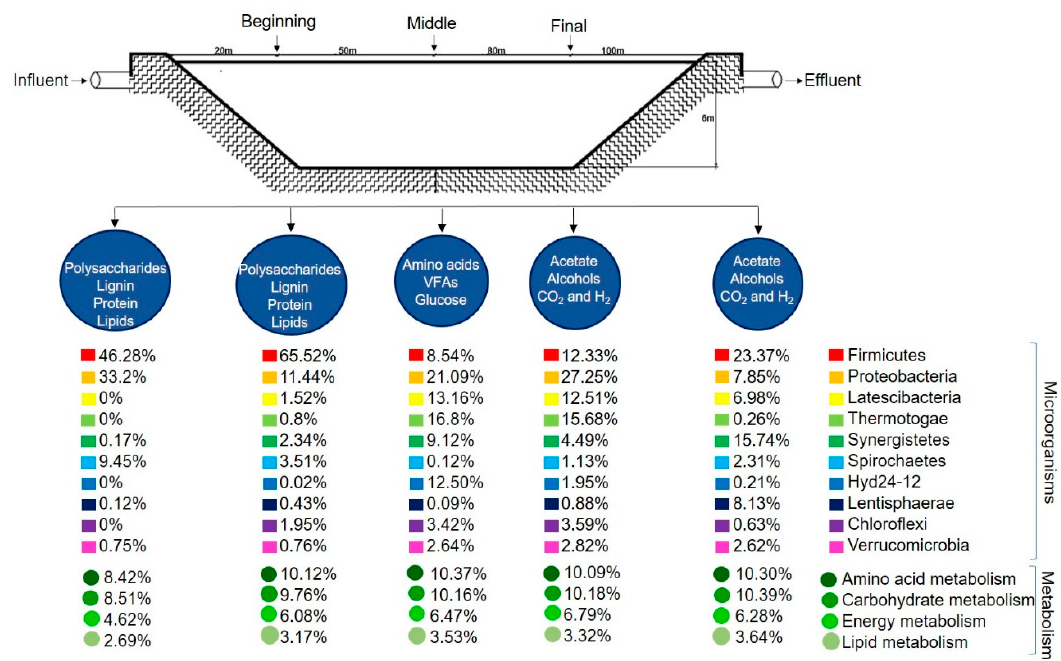
Figure 7. Overview of the bacterial population and metabolic pathways in the di ff erent sampling sites of the biodigester.